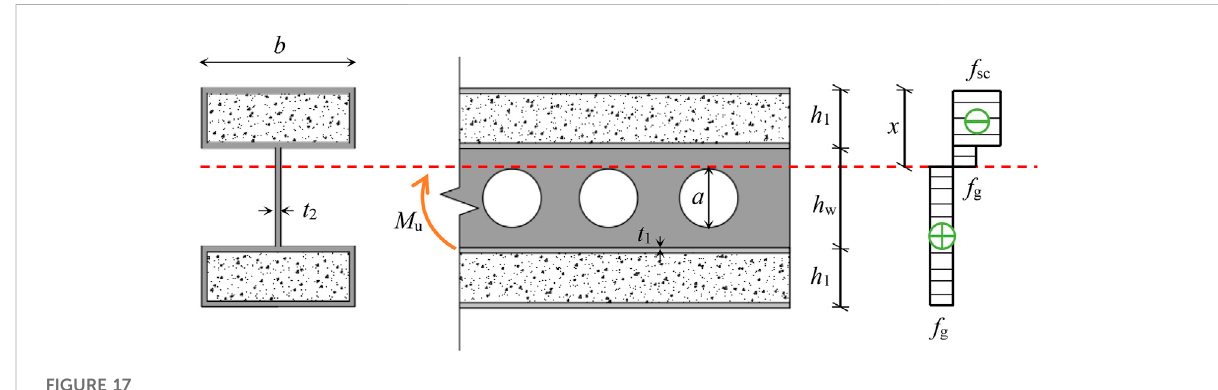
FIGURE 17 Calculation diagram of composite beams.